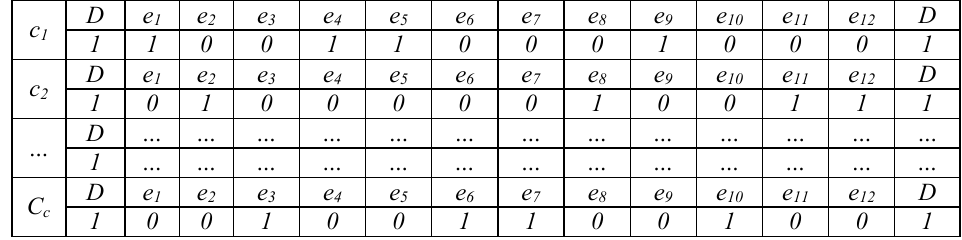
Figure 3. Encoding scheme of a particle for a discrete PSO.